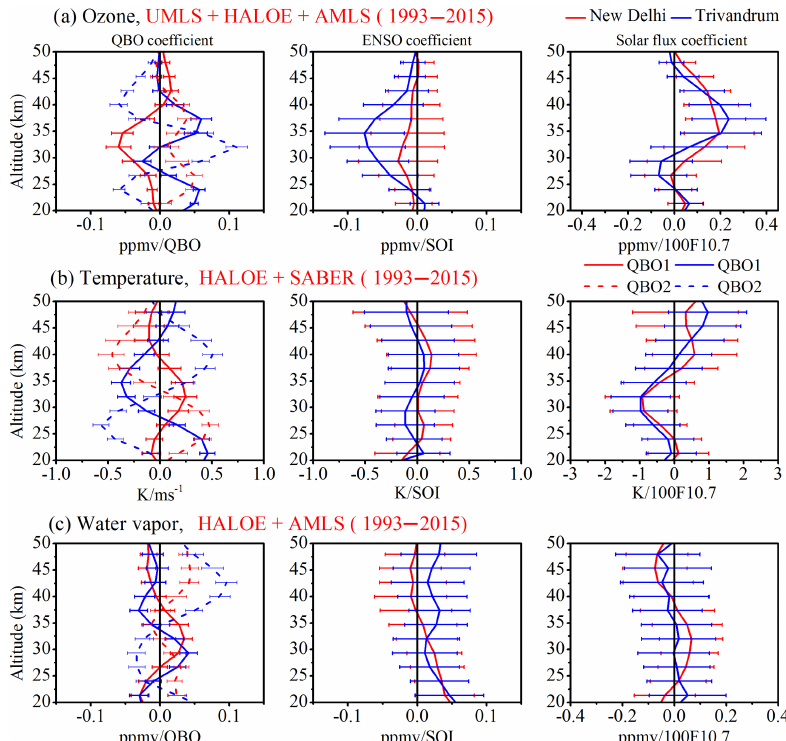
Figure 7. Altitude profile of the response of the (a) ozone mixing ratio obtained using combined measurements of UMLS, HALOE, and AMLS, (b) temperature from HALOE and SABER, and (c) water vapor mixing ratio from HALOE and AMLS over Trivandrum (blue) and New Delhi (red) to the QBO, ENSO, and the solar cycle. The solid line represents 30hPa QBO wind (QBO 1 ) and the dashed line represents 50hPa QBO wind (QBO 2